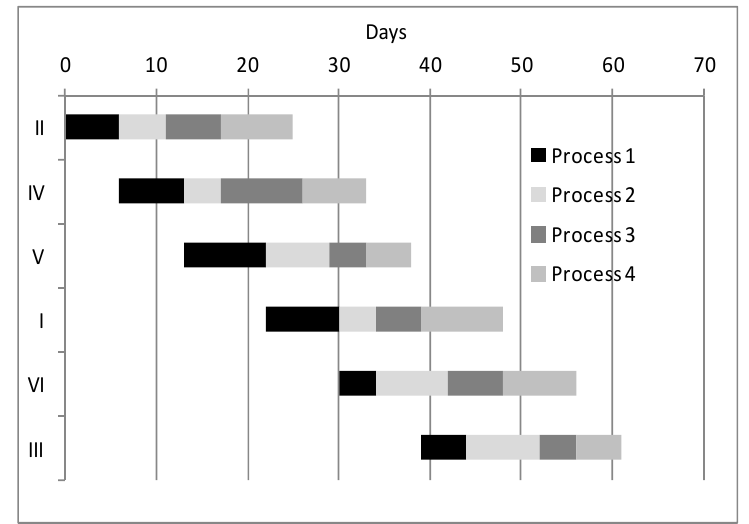
Figure 4. Example: optimal schedule with the constraint that zones IV, V, and I are to be developed in sequence.